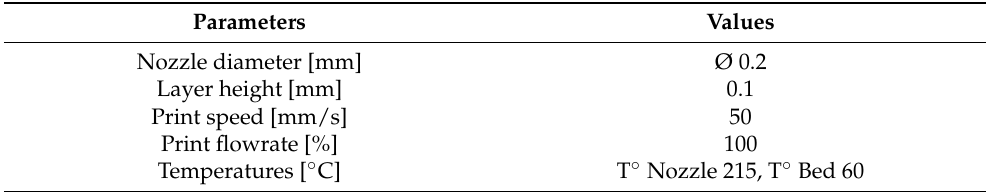
Table 3. FFF process